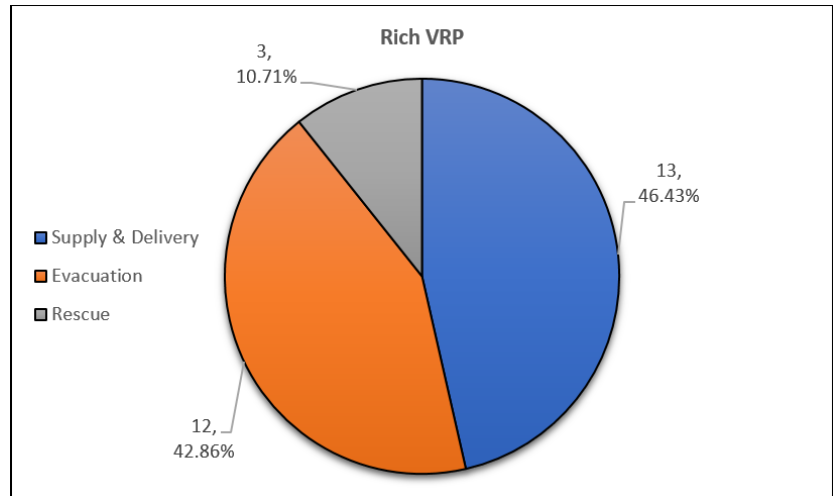
Figure 15. Selected Humanitarian Operation based on RVRP.